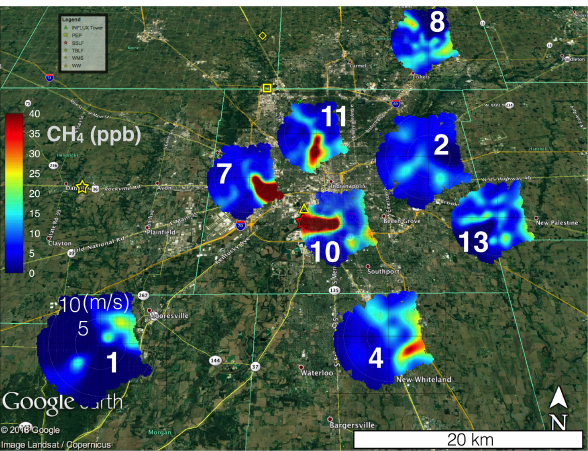
Figure 8. © Google Earth image overlaid with bivariate polar plots (Sect. 2.5) of the CH 4 enhancements at nine INFLUX towers in In- dianapolis using the criterion 1 background (Table 1) for the full years of 2014 and 2015 over the afternoon (12:00–16:00LST). The wind speed scale is only labeled at site 1; other sites follow the same convention. The legend indicates known sources of CH 4 : Pan- handle Eastern Pipe Line (PEP), South Side landfill (SSLF), Twin Bridges landfill (TBLF), Waste Management Solutions (WMS), and a wastewater treatment facility (WW). The known magnitudes of sources that are in Marion County (PEP, SSLF, and WW) are re- ported in Sect. 2.7. Magnitudes of TBLF and WMS according to EPA are approximately 5mols − 1 . The largest known source on the map is SSLF.